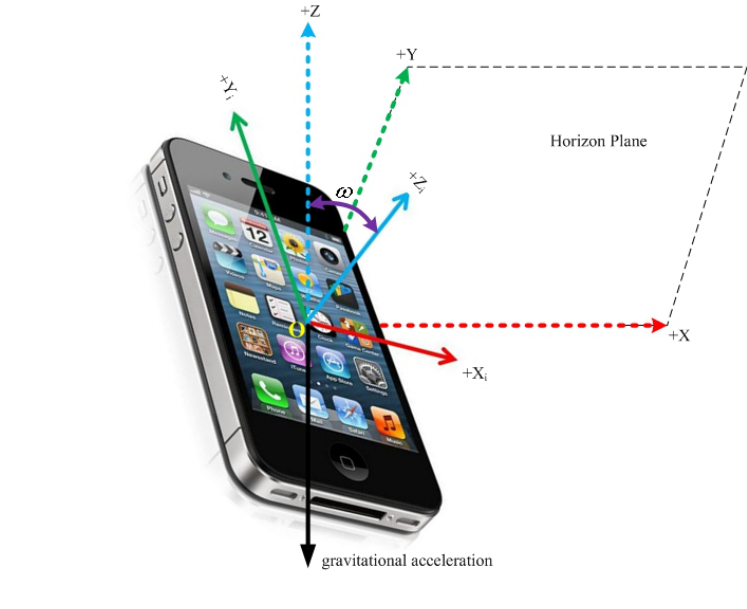
Figure 2. iPhone inertial coordinate system and reference coordinate